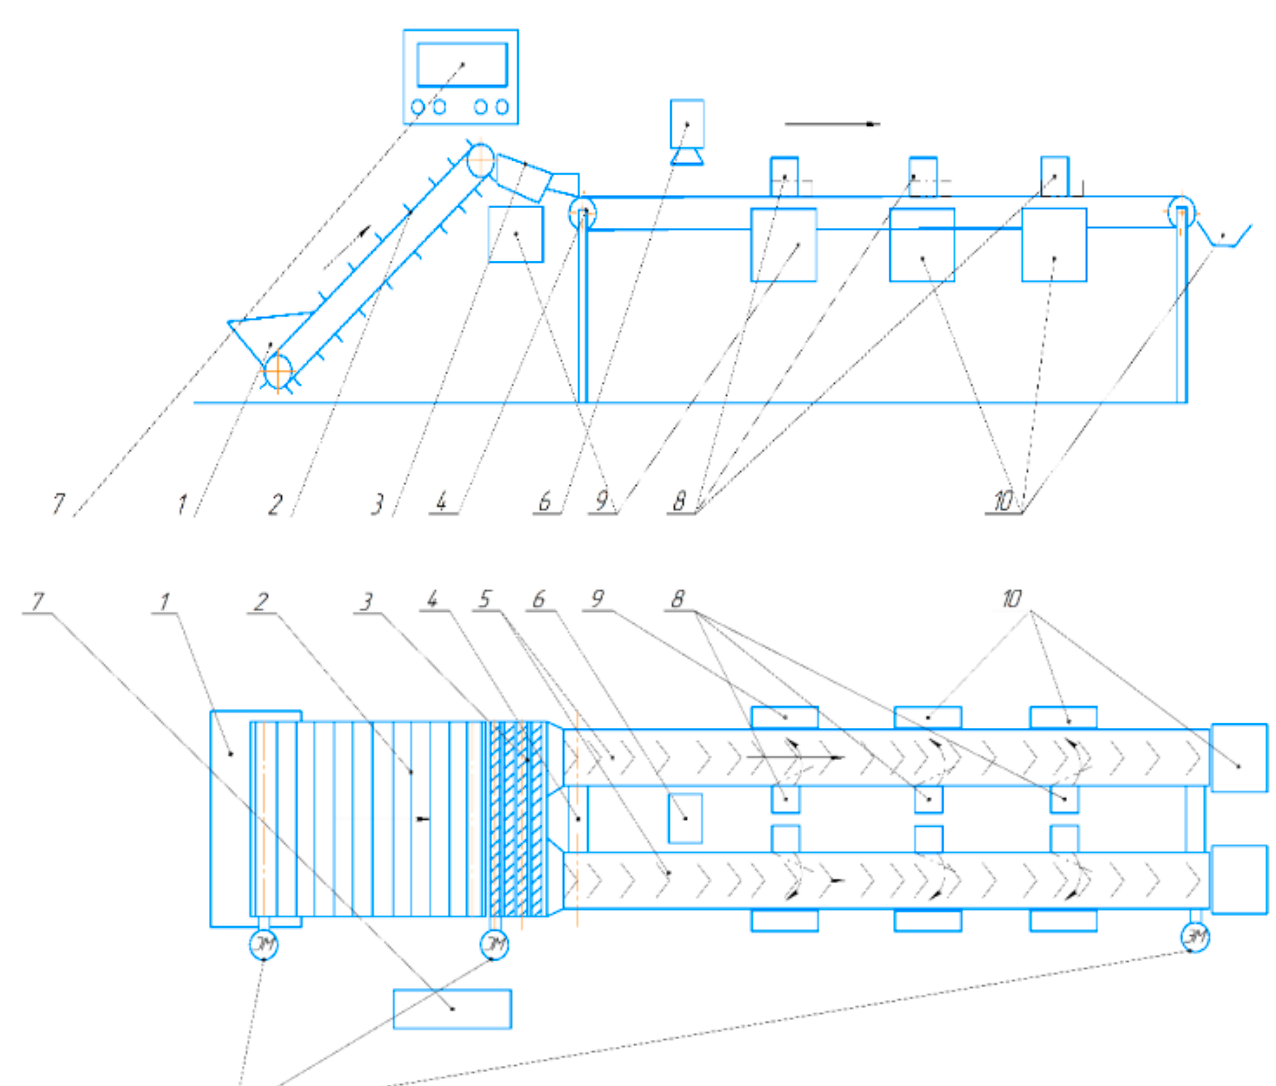
Figure 1. Technological scheme of a machine for the post-harvest treatment of potato tubers with an automated sorting system: 1—receiving hopper; 2—transfer conveyor; 3—spiral heap cleaner guides; 4—conveyor sorting device; 5—conveyor belts; 6—camera; 7—control unit; 8—executive mechanisms; 9 and 10—trays; 11—electric motors.